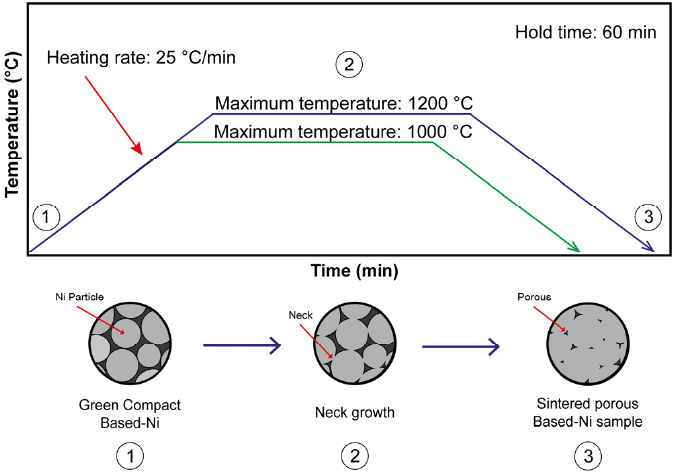
Figure 12. Thermal cycle conditions for the sintering of Ni-based electrodes.